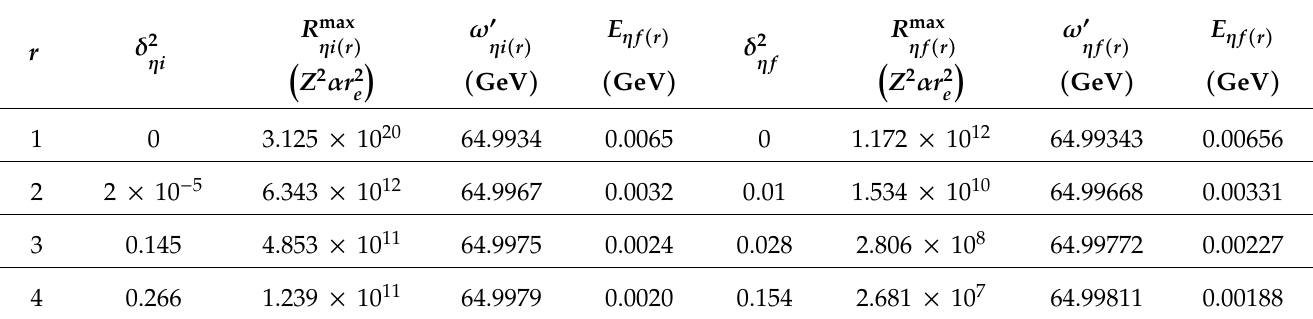
Table 2. The values of the resonant frequency and the square of the outgoing angle of the spontaneous gamma quantum for the maximum value of the maximum resonant di ff erential cross-section (see Figure 3). The frequency and intensity of the electromagnetic wave are ω = 20 keV